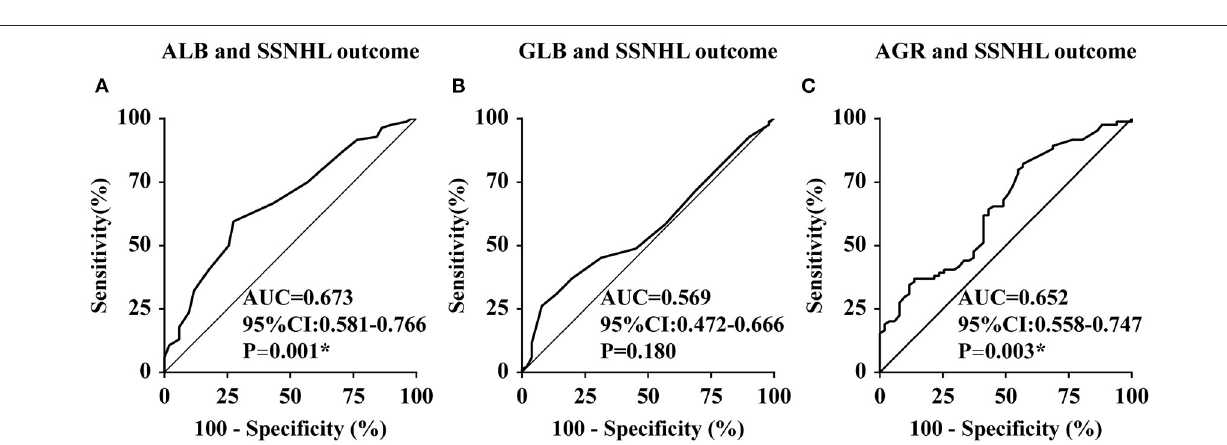
FIGURE 2 | Plots of liver functions vs. the recovery of hearing level. ALB, albumin; GLB, globulin; AGR, albumin-to-globulin ratio; ALT, alanine aminotransferase; AST, aspartate aminotransferase; TBIL, total bilirubin. Data are presented as correlation coefficients (R) and P values. (A–F) represent the relationship of ALB, GLB, AGR, ALT, AST, and TBIL vs. the recovery of hearing level, respectively.